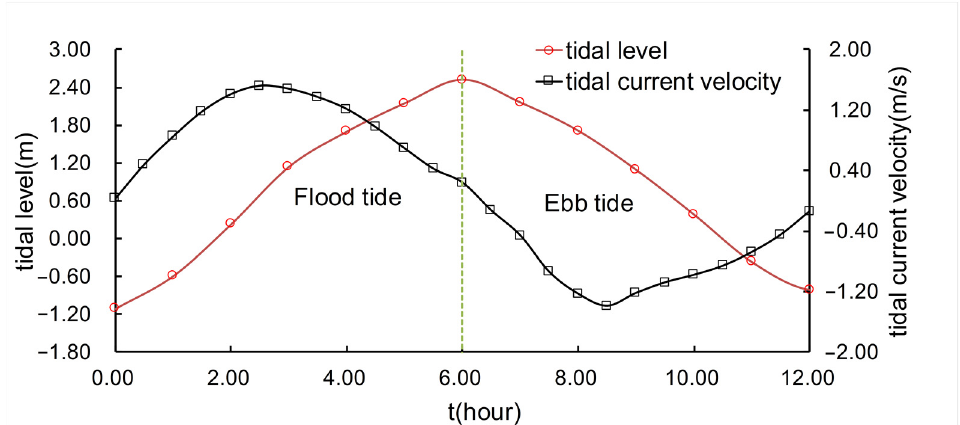
Figure 2. Typical time process of tidal velocity and water level in Hangzhou Bay.